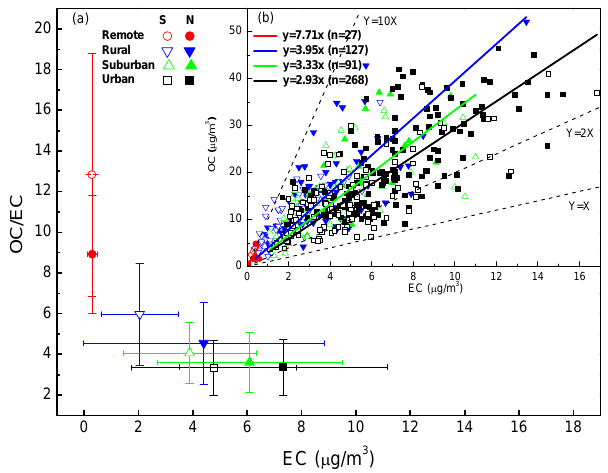
Figure 4. (a) Averaged ambient OC / EC ratios versus EC concen- trations in PM 2 . 5 with standard deviations from seasonal obser- vation data at southern (S; open symbols) and northern (N; solid symbols) remote, rural, suburban, and urban sites in China; and (b) regressions of observed seasonal means of OC and EC con- centrations in PM 2 . 5 for remote, rural, suburban, and urban sites in China. The lines indicating OC / EC = 1 ( Y = X ), 2 ( Y = 2 X ), and 10 ( Y = 10 X ) are plotted for